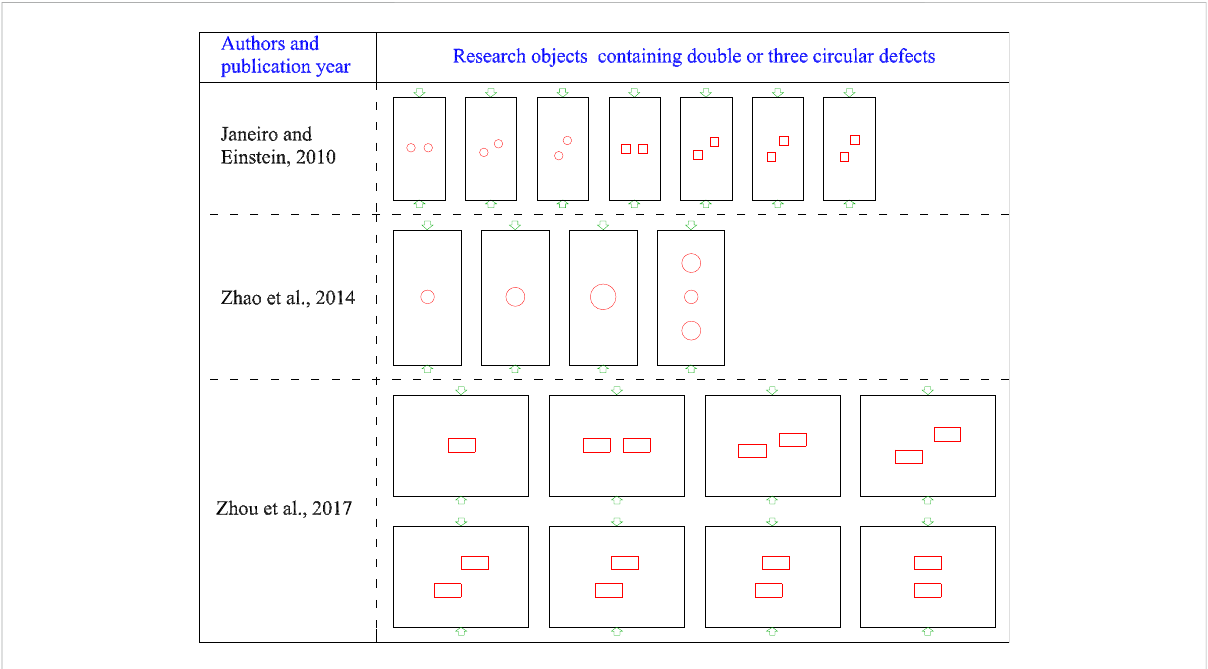
Rock or rock-like specimens containing double and three circular or rectangular